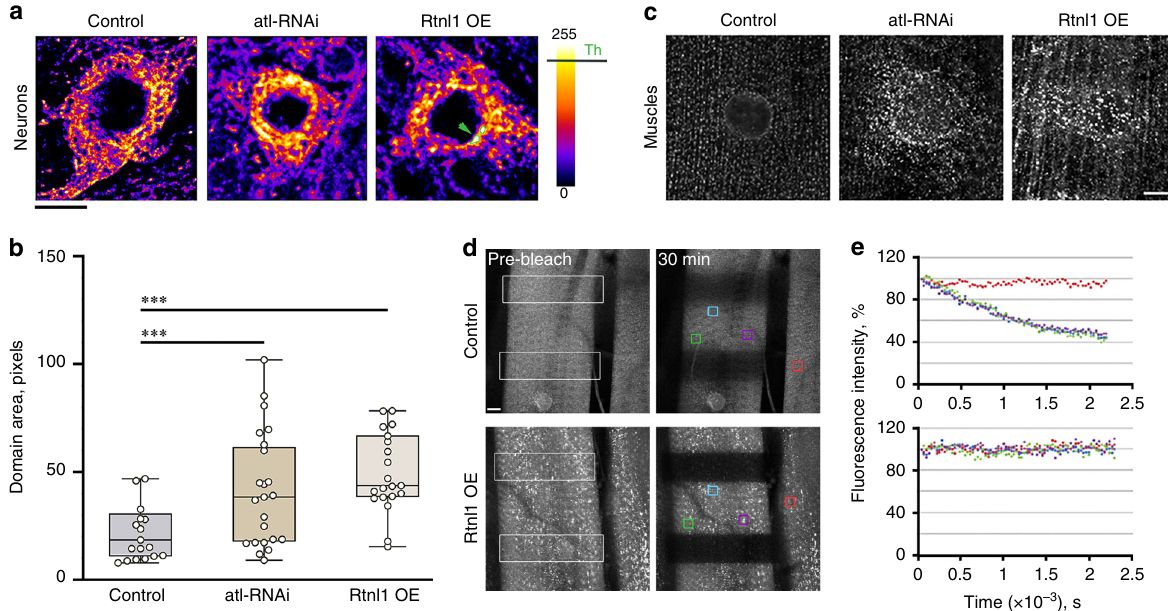
Fig. 2 Rtnl1 overexpression and loss of atlastin give rise to comparable defects in ER distribution and connectedness. a Deconvolved confocal STED projections showing comparable changes in the ER network appearance produced by Rtnl1 overexpression ( Rtnl1 OE) and knockdown of atlastin ( atl -RNAi) in Drosophila neurons labeled with the ER marker GFP-KDEL. The pseudo-color representation highlights emergence of bright fl uorescent domains (examples marked by the arrow) in Rtnl1 overexpression and atl -RNAi. Scale bar 5 μ m. b Rtnl1 overexpression and atl -RNAi show an increase of the total area of bright fl uorescent domains (calculated using non-deconvolved STED projections with the brightness threshold Th = 200 indicated in ( a )). Five randomly selected cells (total of 20 domains) were analyzed for each condition. Statistical signi fi cance: unpaired two-tailed t test, *** p < 0.001. Boxplots show IQR, whiskers indicate minimum and maximum of the dataset. c Emergence of bright fl uorescent punctae in third instar larva muscle labeled by GFP- KDEL upon Rtnl1 overexpression or atl -RNAi. Scale bar 10 μ m. d Representative images of FLIP performed by repetitive photobleaching of two regions (white outline box) in control and Rtnl1 overexpressing Drosophila larva muscles labeled with GFP-KDEL (left). Scale bar 10 μ m. e Rates of fl uorescence loss in four independent regions (color boxes) of control (top) and Rtnl1 overexpressing (bottom) muscle were quanti fi ed and graphed. The red box was chosen on an adjacent unbleached muscle as a control. Source data are provided as a Source Data fi